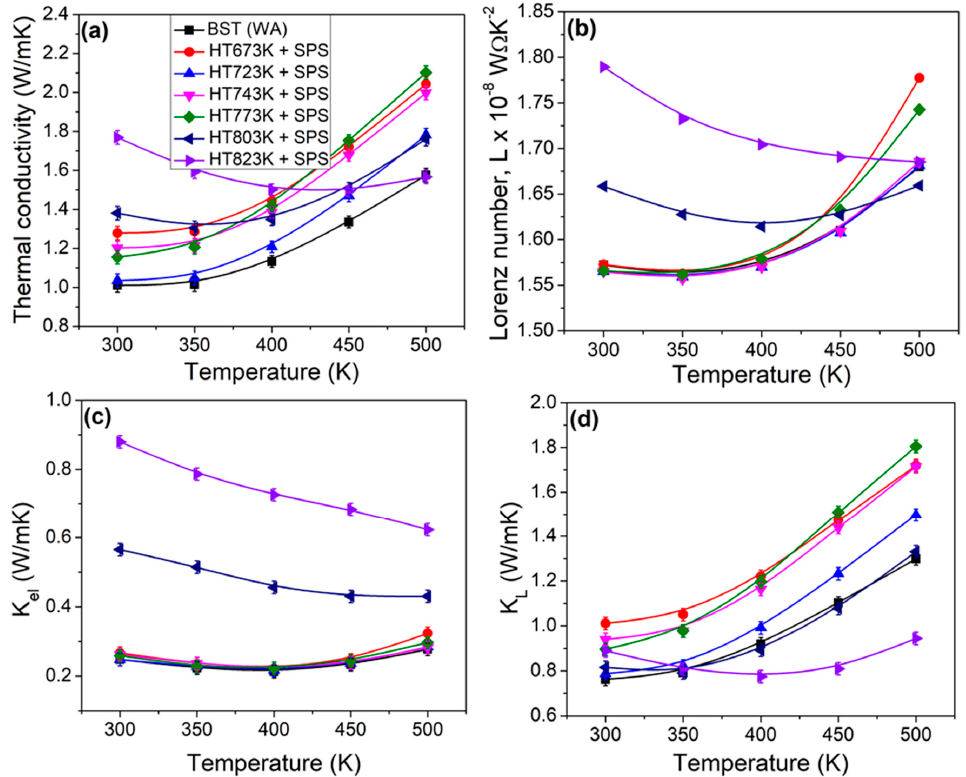
Figure 5. Temperature dependence of thermal transport properties for the bulk samples obtained by powder heat treatment at different temperatures and consolidation: ( a ) total thermal conductivity ( κ ), ( b ) Lorenz number ( L) , ( c ) electronic thermal conductivity ( κ el ), and ( d ) lattice thermal conductivity ( κ L ).